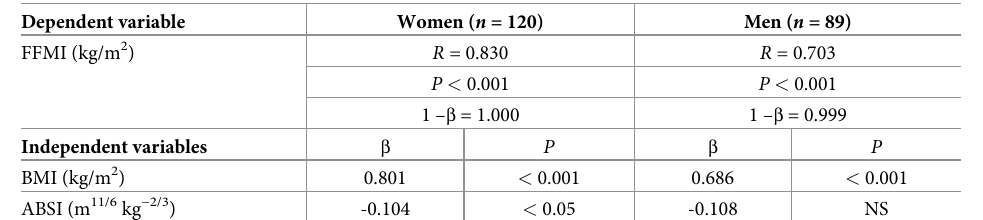
Table 5. Multiple linear regression